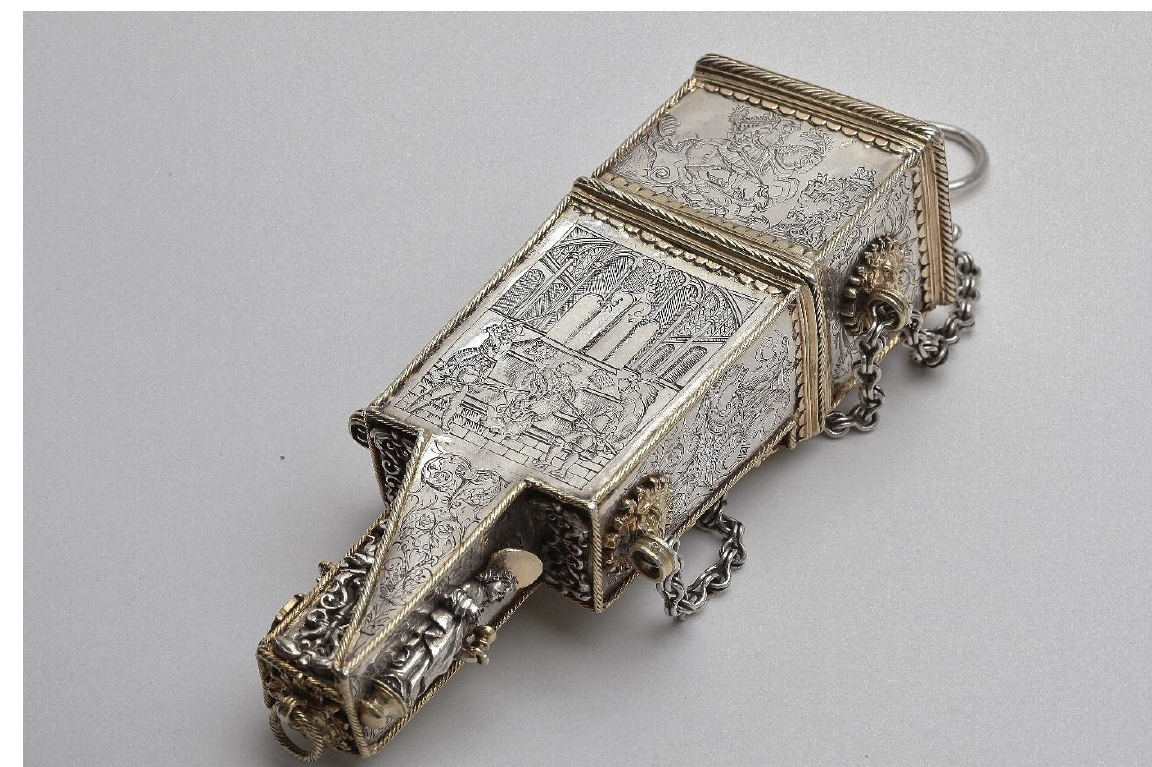
Figure 1. Instrument case, front. From the collections of the Worshipful Company of Barbers, London .